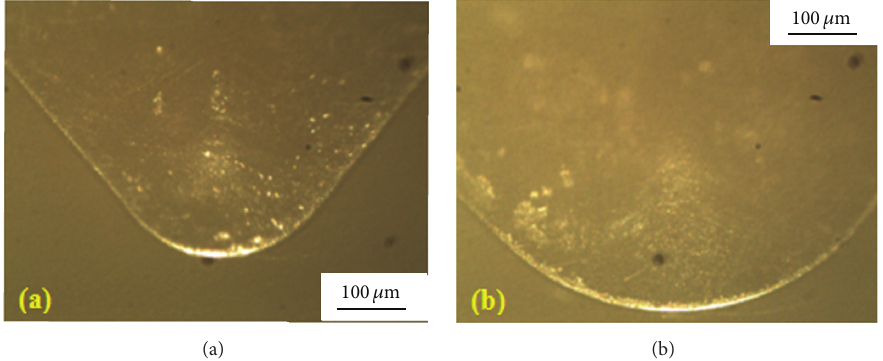
Figure 14: Microtexture of insert before turning: (a) 0.4mm nose radius and (b) 0.8 mm nose